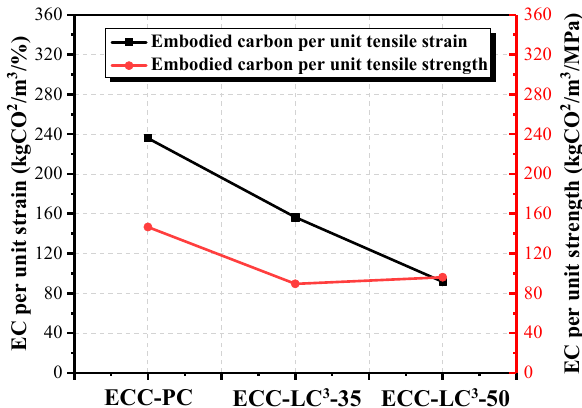
Figure 17. Comparison of the energy consumption of ECC per unit tensile strain and per unit tensile strength.